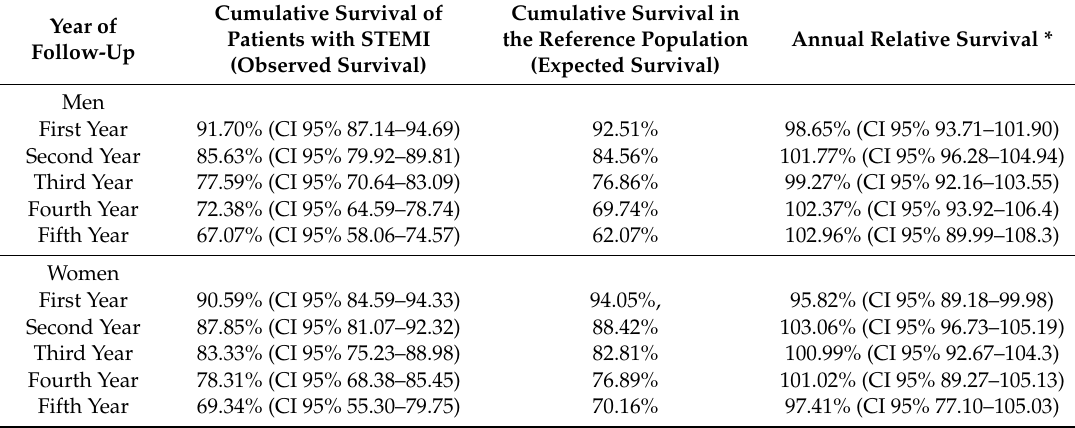
Figure 5. 95% confidence interval of the observed survival compared with the expected survival. Only patients who survived the first 30 days after the ST elevation myocardial infarction, stratified by sex. Table 5. Observed and expected survival during the follow-up stratified by sex and calculated by year of follow-up for patients who survived the first 30 days after the STEMI. Relative survival by annual intervals are also